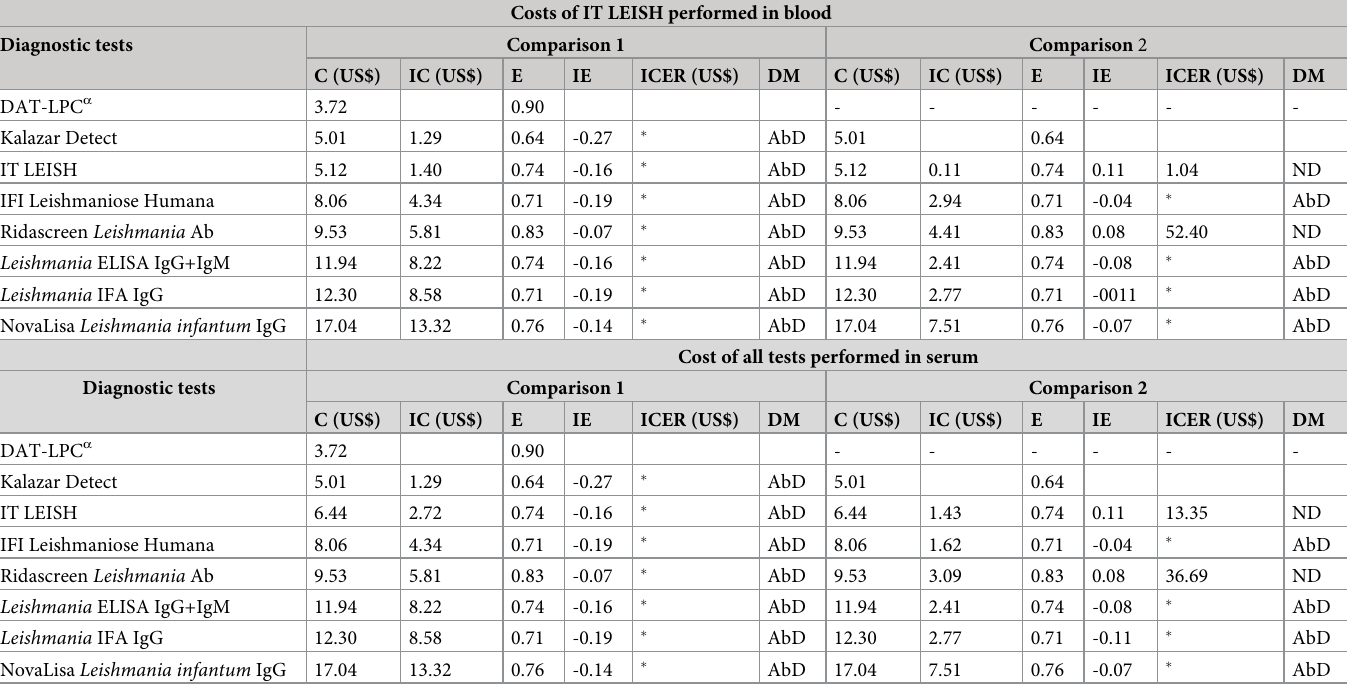
Table 4. Cost-effectiveness analysis of diagnostic tests for visceral leishmaniasis for HIV infected